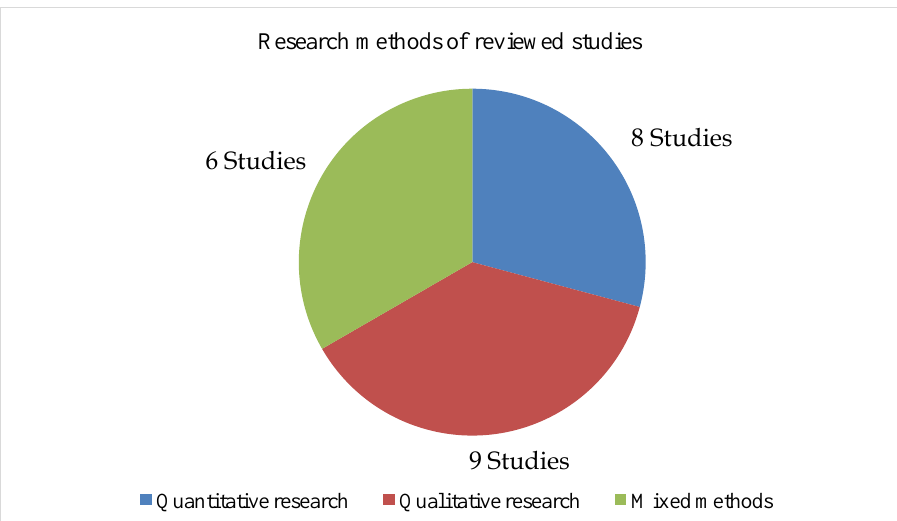
Figure 3: Research Methods of Reviewed